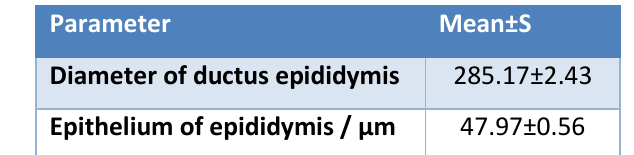
Table, 2: Shows the length and diameter of cranial, middle and caudal parts of the ductus deference. Parameter of ductus deferens